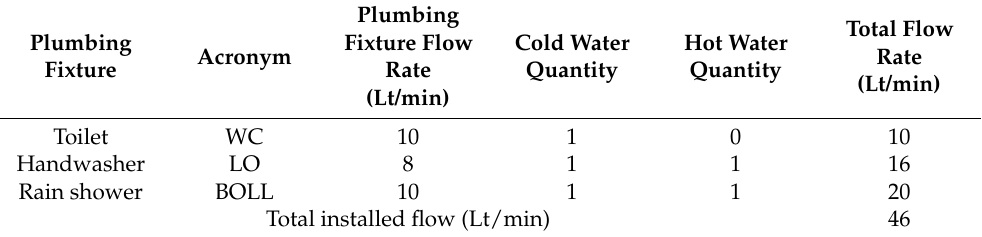
Table 18. Total installed loads chart for type 2 retail store.